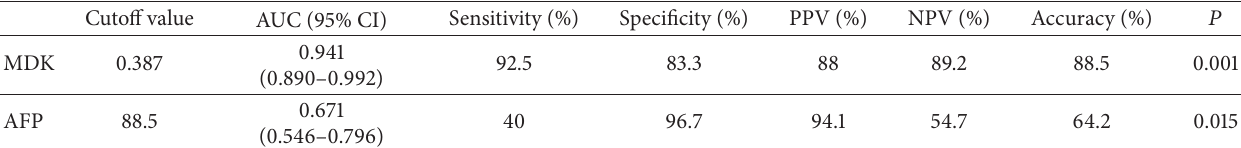
Table 2: The diagnostic performance of the best cutoff values of AFP and MDK for discriminating HCC group from LC group. Cutoff value